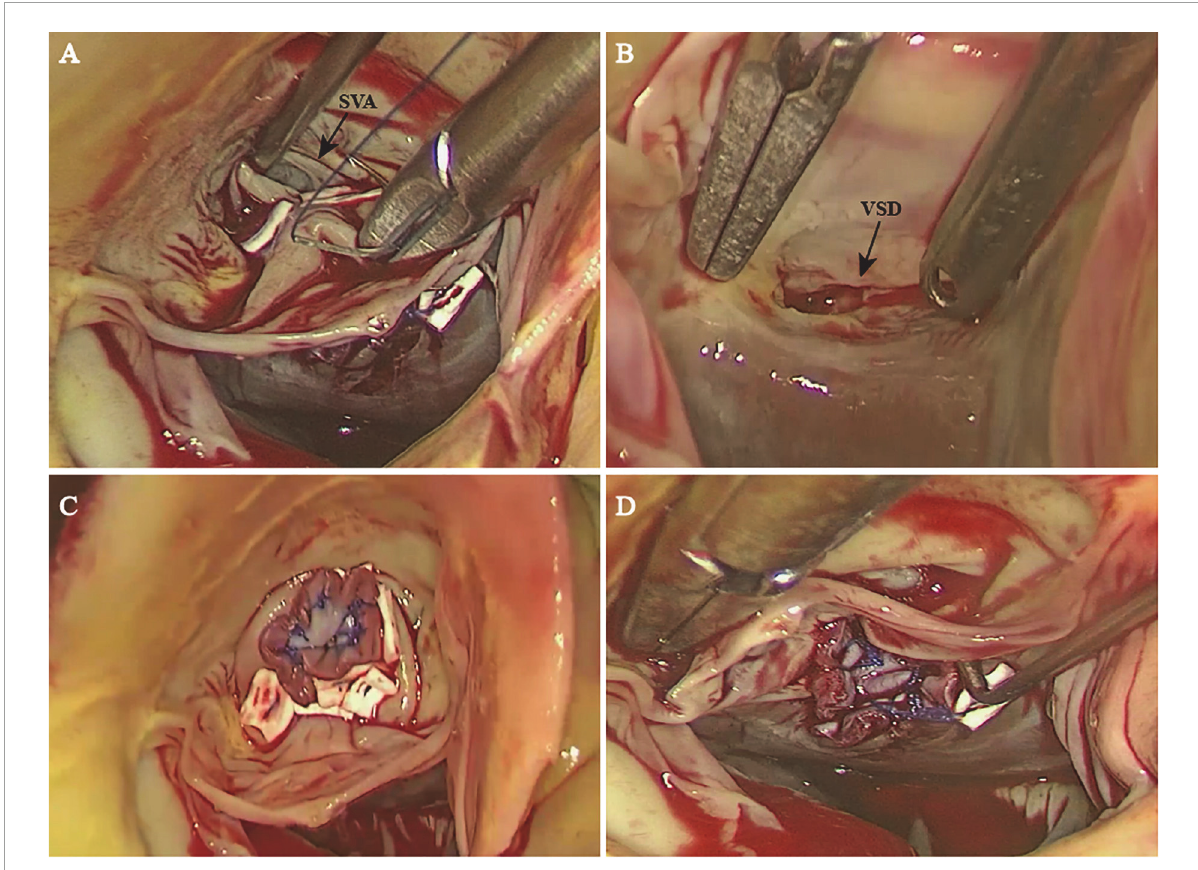
FIGURE3 The sinus of Valsalva with a ruptured right coronary sinus (A) and the ventricular septal defect (B) were exposed well through the endoscope. The sinus of Valsalva aneurysm (C) and the ventricular septal defect (D) were successfully repaired with a patch. SVA, sinus of Valsalva aneurysm; VSD, ventricular septal